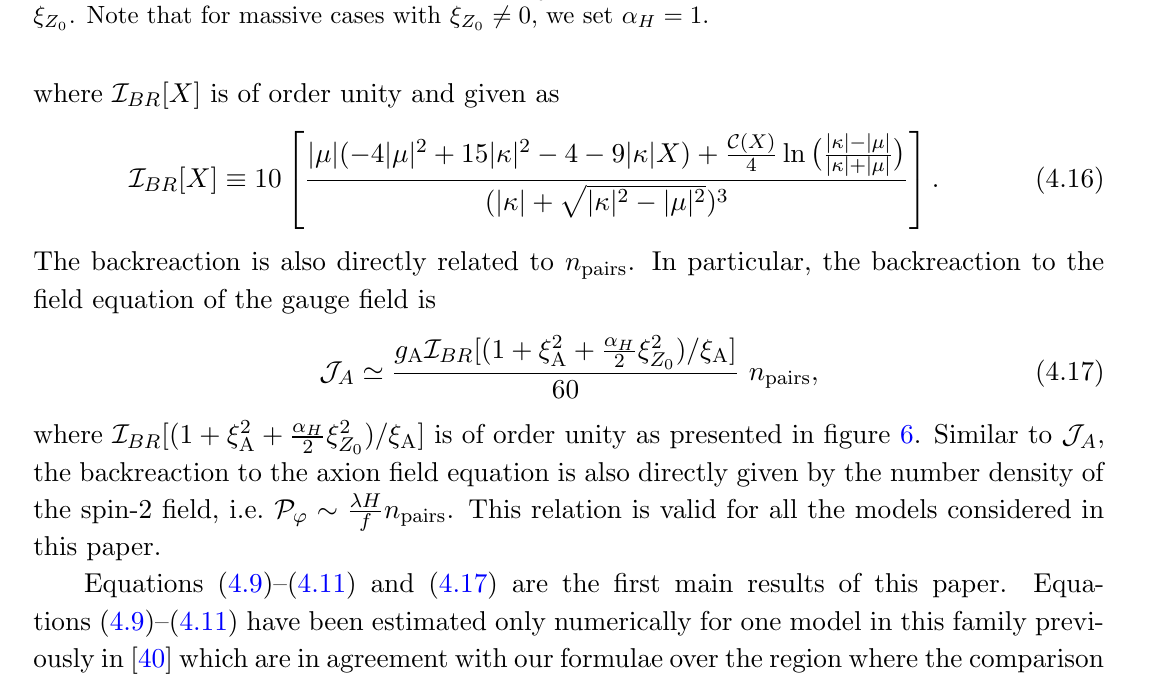
Figure 6 . The prefactor I BR [(1 + (cid:24) 2 (cid:24) Z . Note that for massive cases with (cid:24) Z 0